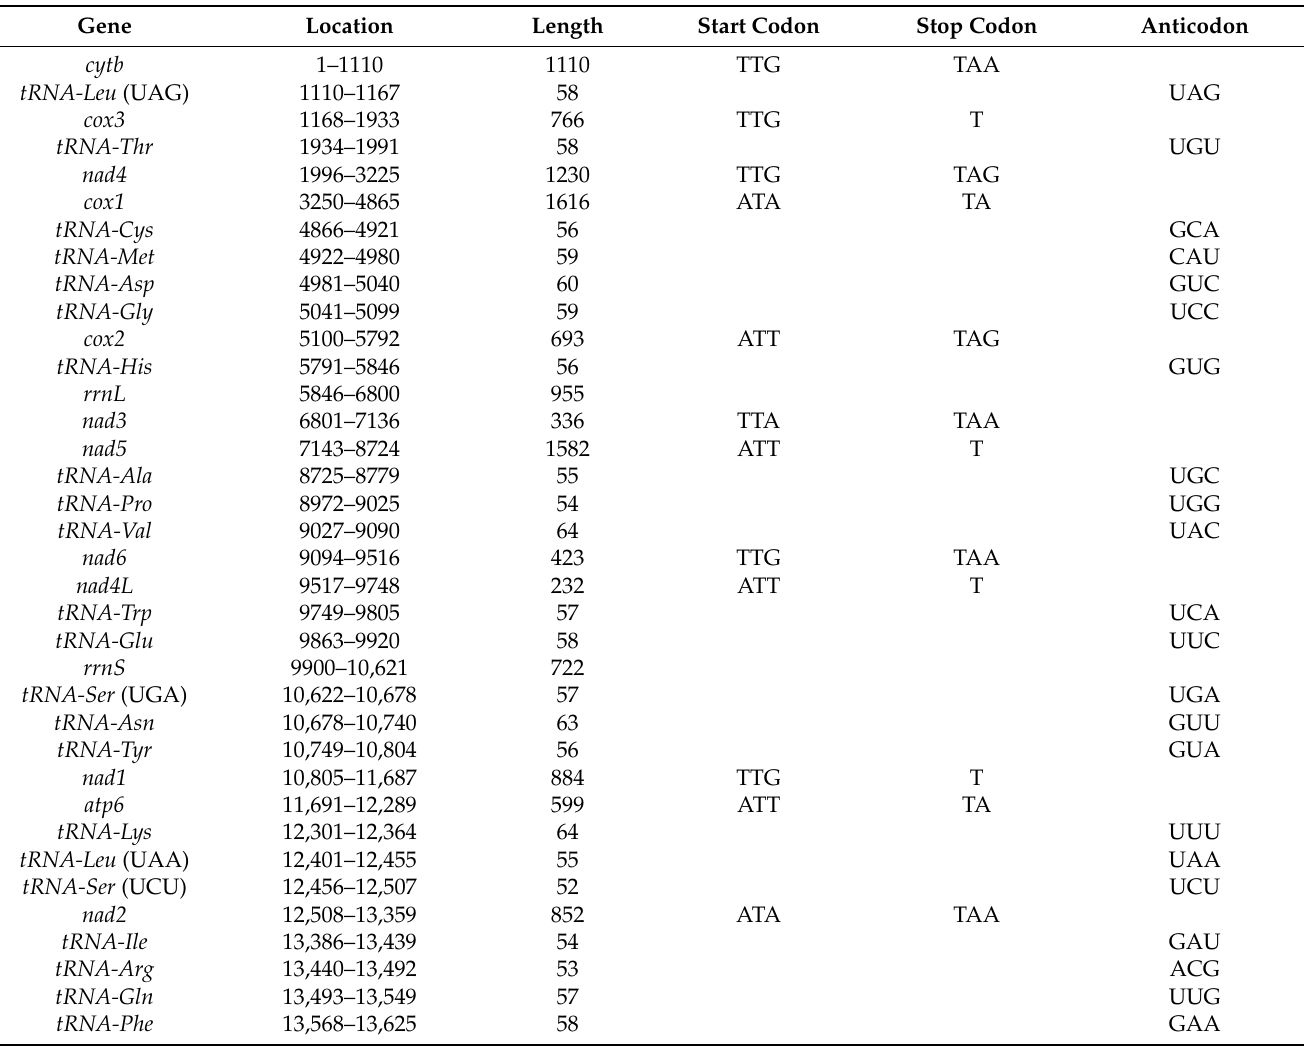
Figure 3. Relative synonymous codon usage (RSCU) and codon numbers in V. eleguneniensis mtDNA. Codon families are provided on the X-axis, and the RSCU of each codon is represented by different color bars (left axis scale). The codon numbers are indicated by the green line graph (right axis scale). Table 1. Structures and organizations of V. eleguneniensis mtDNA.